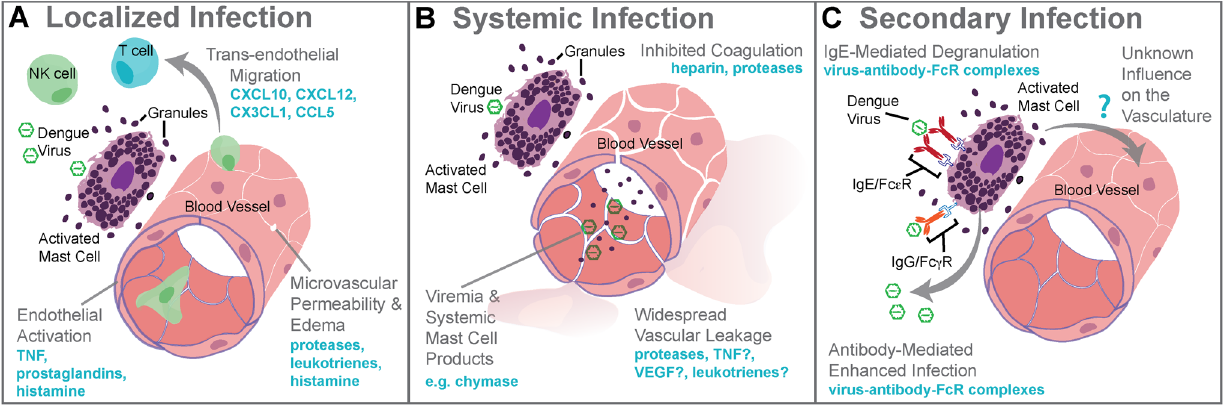
Figure 1. Mast cell–augmented immune responses to dengue virus infection. (A) During localized infection of the skin, DENV triggers degranulation of MCs and release of de novo synthesized inflammatory mediators. MC-derived mediators, including proteases, leukotrienes, and histamine, promote edema within the site of infection as a result of increased microvascular permeability. MC products also stimulate the rolling of leukocytes along areas of activated endothelium and chemokines direct the recruitment of cytotoxic cells such as NK cells, NKT cells, and T cells into the infection site. The antiviral inflammatory program promoted by MCs at the site of infection aids viral clearance and limits spread beyond the site of initial infection to lymph nodes. (B) Systemic infection with DENV is characterized by widespread vascular leakage and virema coincides with elevated levels of MC products, such as the protease chymase, in the serum. Many MC products are vasoactive, including leukotrienes, TNF, VEGF, and others, and these are likely to act together to enhance the vascular leakage that occurs during viremia. (C) During secondary infection, pre-formed antibodies are hypothesized to cause ADE when they are non-neutralizing. For mast cells, ADE is also possible as a result of uptake of antibody virus complexes through the Fc c R. MC degranulation responses can also be enhanced through crosslinking of Fc e Rs when bound to DENV-specific IgE. Although the influence of DENV-specific antibodies acting through MCs has not fully been investigated, augmented MC activation during secondary infection should also enhance immune responses, presumably including immune-mediated vascular